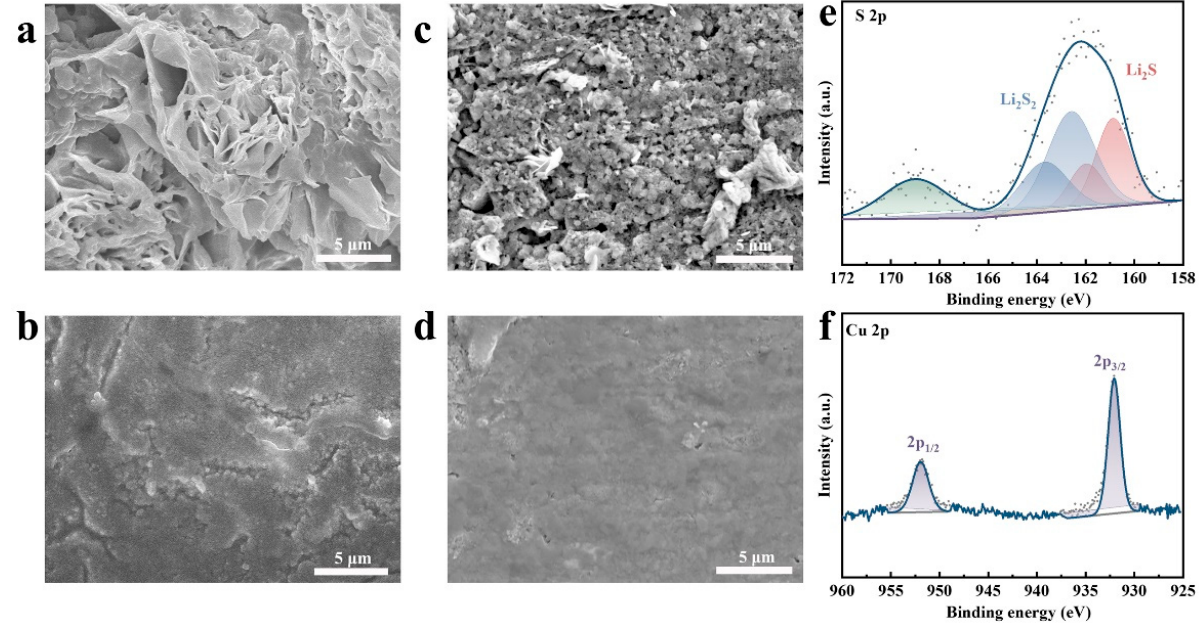
Figure 7. SEM images of the Li metal, which are disassembled from ( a ) Li|LAGP|Li and ( b ) Li|Li 2 S/Cu@LAGP|Li cells for 50 cycles at 0.1 mA cm − 2 . SEM patterns of the surface of LAGP pellets, which are disassembled from ( c ) Li|LAGP|Li and ( d ) Li|Li 2 S/Cu@LAGP|Li cells. XPS spectra of ( e ) S 2p and ( f ) Cu 2p at the surface of the Li 2 S/Cu@LAGP electrolyte.